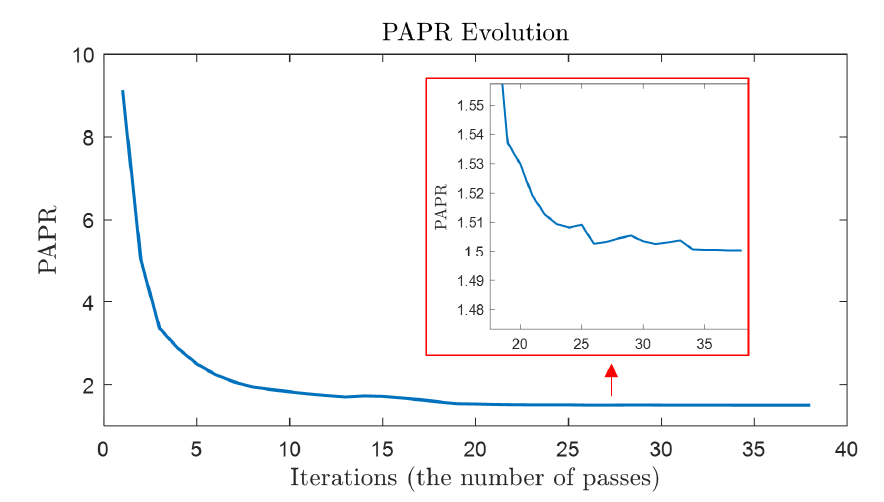
Figure 9. PAPR evolution over iterations.